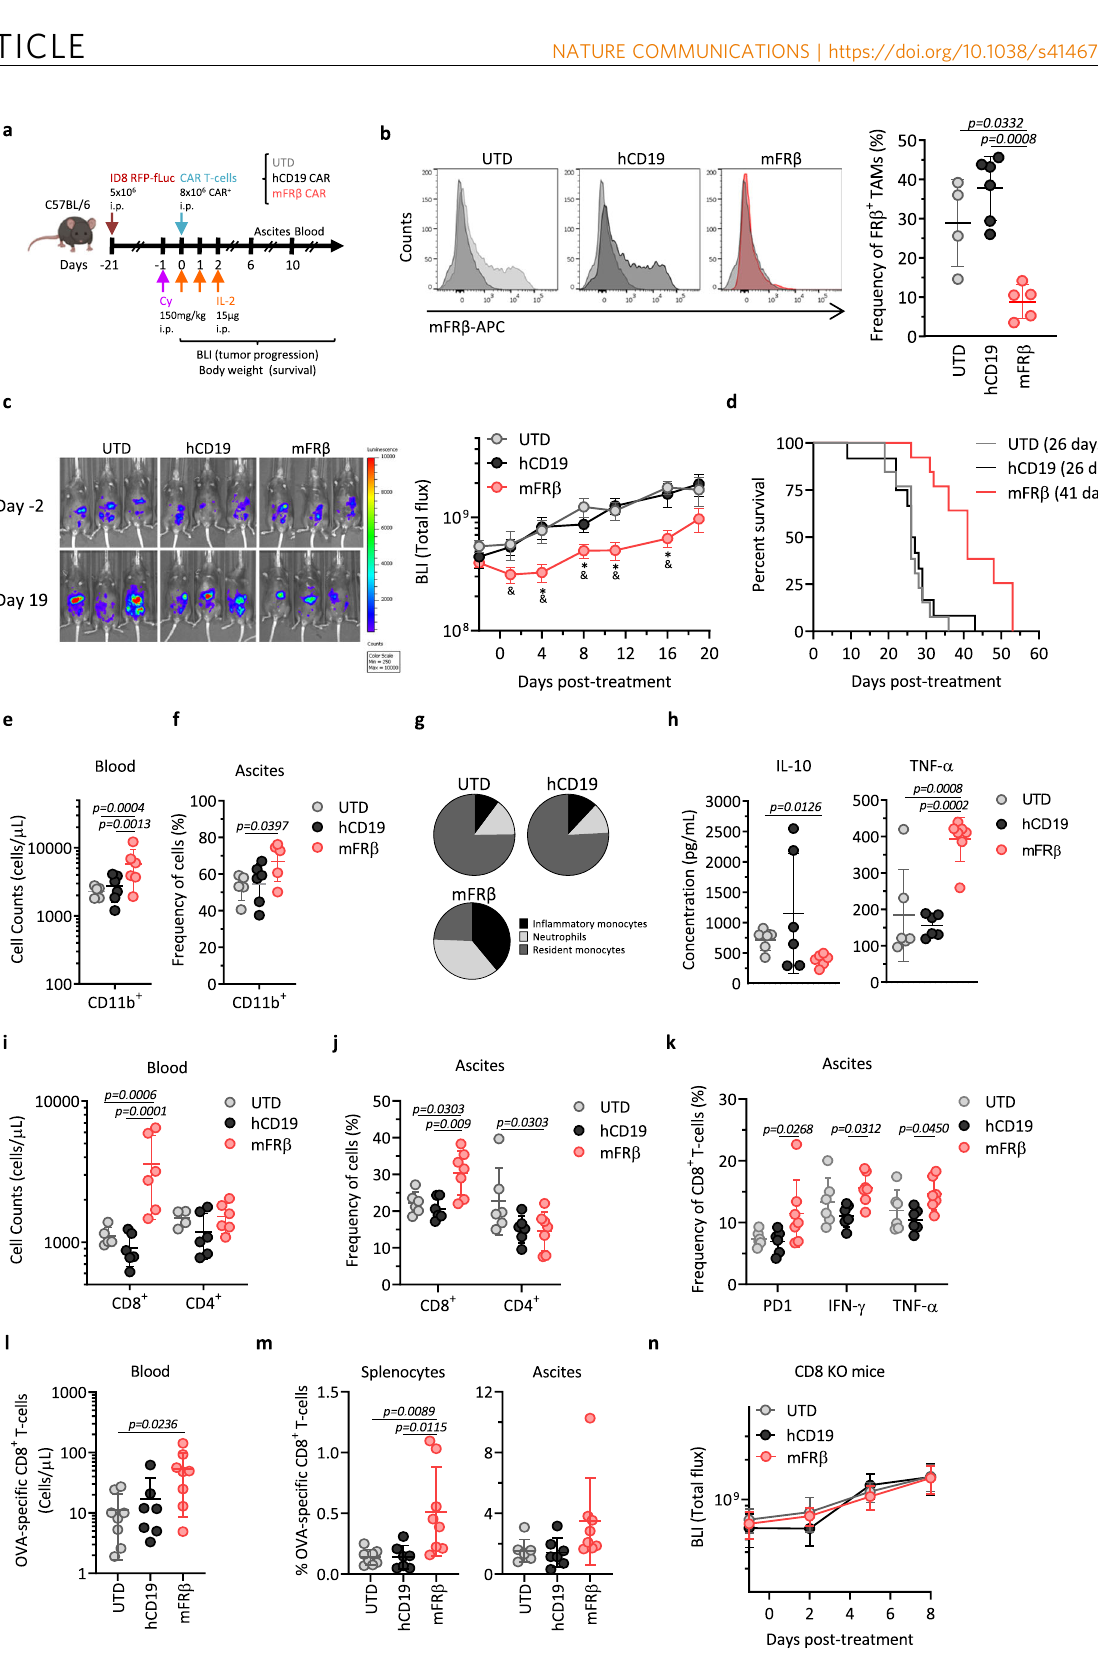
Fig. 8a, b), or the combination of both mFR β - and hMeso-speci fi c CAR-T cells given simultaneously or sequentially as depicted in Fig. 6a, after Cy preconditioning. In these studies, a suboptimal T cell dosing regimen was used in order to reveal a potential